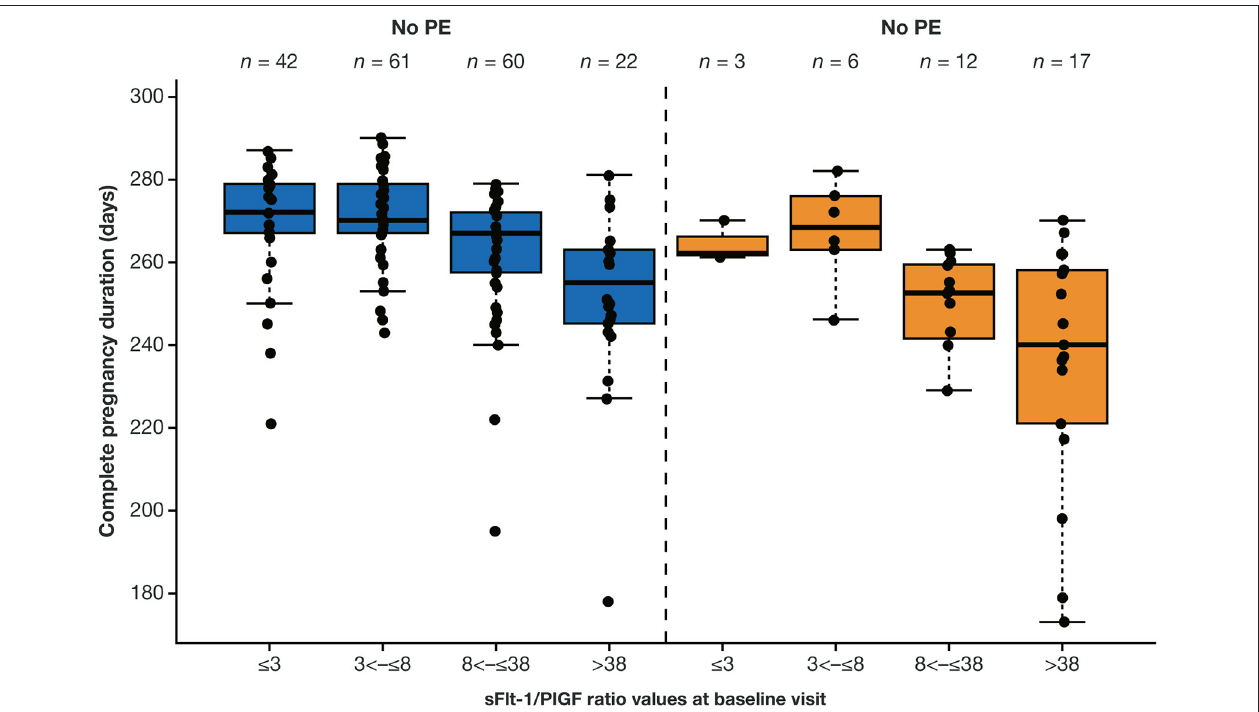
FIGURE 3 | Distribution of complete pregnancy duration according to sFlt-1/PlGF ratio at baseline visit by overall preeclampsia status. a,b a A total of 223 participants from China were eligible for this analysis. b The boxes represent the first and third quartiles and the median value. The whiskers represent values that are IQR or shorter in cases where the minimal/maximal value lies within 1.5 × the IQR. The boxes represent the median and IQR in log scale. IQR, interquartile range; PE, preeclampsia; PlGF, placental growth factor; sFlt-1, soluble fms-like tyrosine kinase